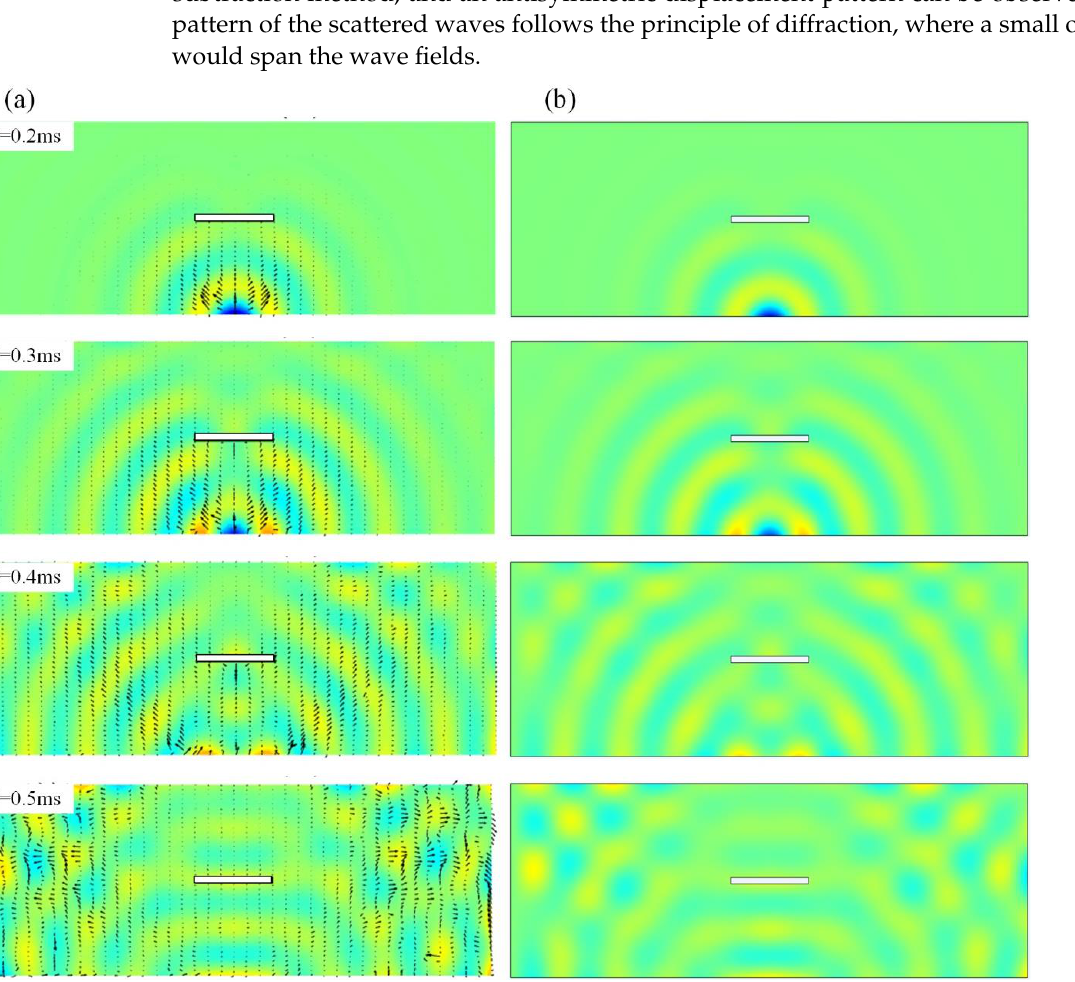
Figure 5. The full-field displacement response within 0.2 to 0.5 ms of the damaged plate ( a ) the semi-analytical method with the power transmission paths. ( b ) The FEM methods.